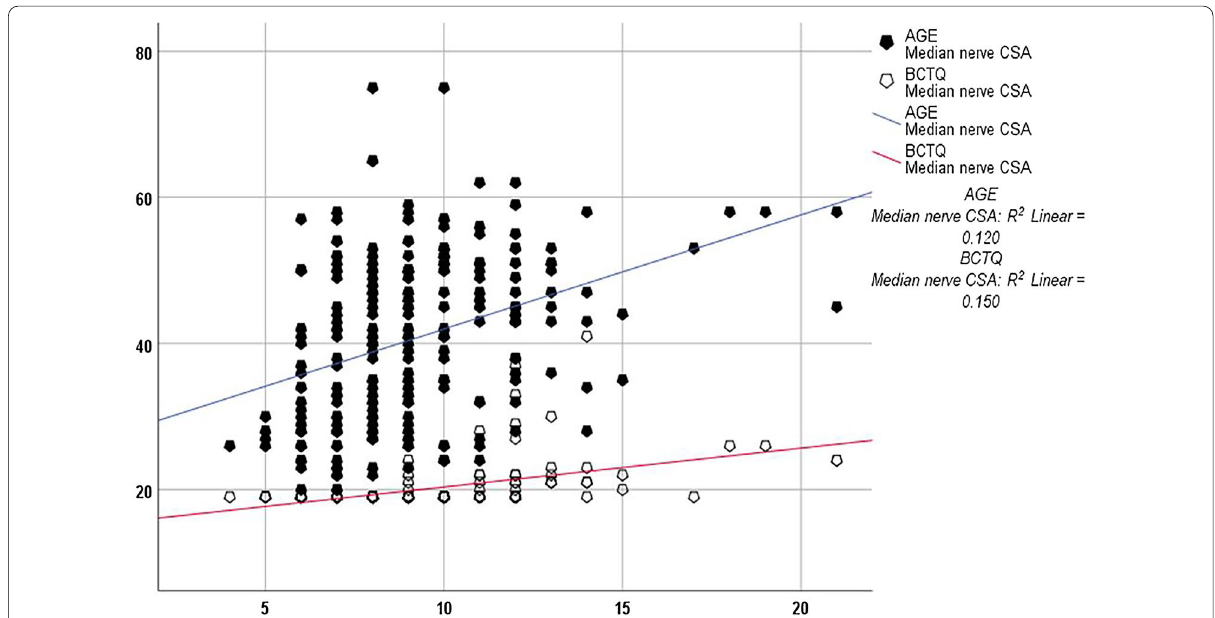
Fig. 1 Correlation between median nerve CSA and both age and BCTQ